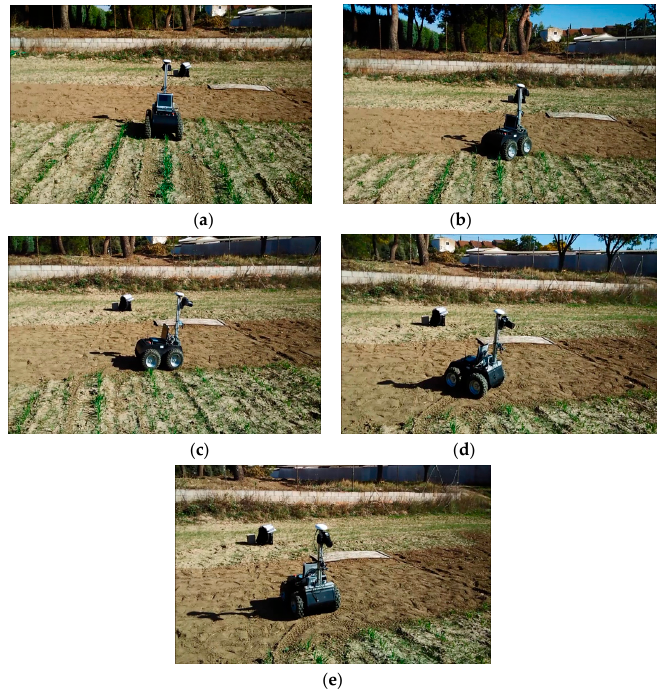
Figure 19. Sequence of manoeuvres performed by the robot to change rows. ( a ) corresponds with manoeuvre 1 in Figure 14, i.e. , the straight-line forward movement; ( b ) with the circular-arc movement, manoeuvre 2; ( c ) with straight-line forward movement, manoeuvre 3; ( d ) with reverse circular-arc movement, manoeuvre 4; ( e ) with straight-line forward movement, manoeuvre 5. Video can be found in [65].